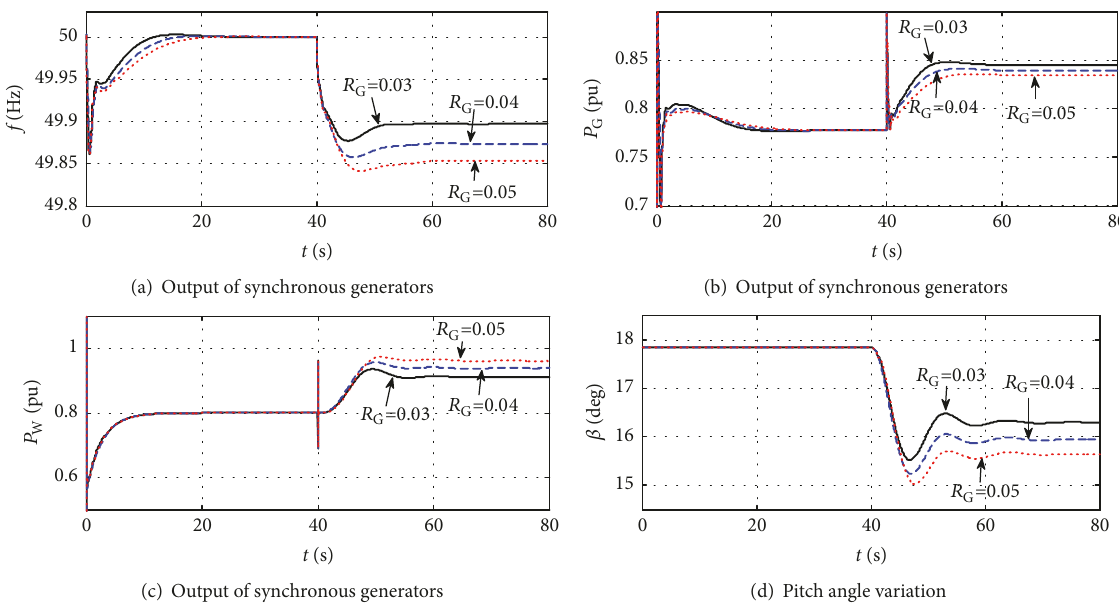
Figure 8: Simulation diagram of the power constant area when frequency variation is greater than 0.2Hz.